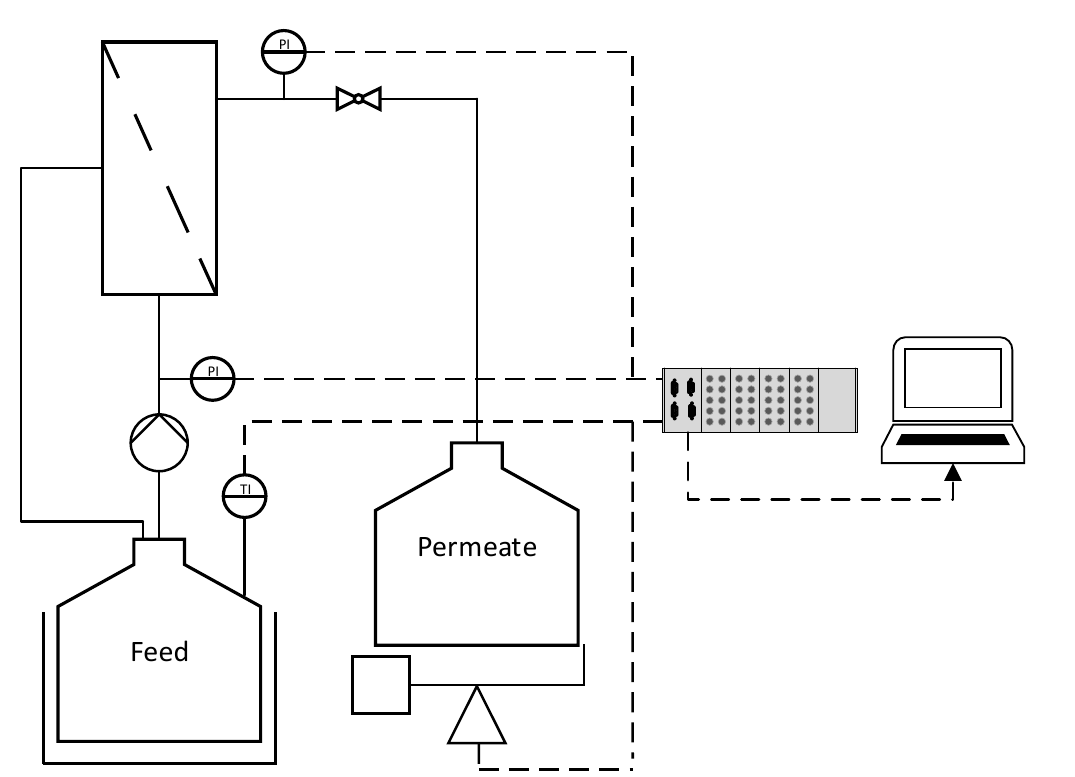
Figure 1. The filtration setup used in this study. Dashed lines indicate data transmission. P = pressure sensor. T = temperature sensor.